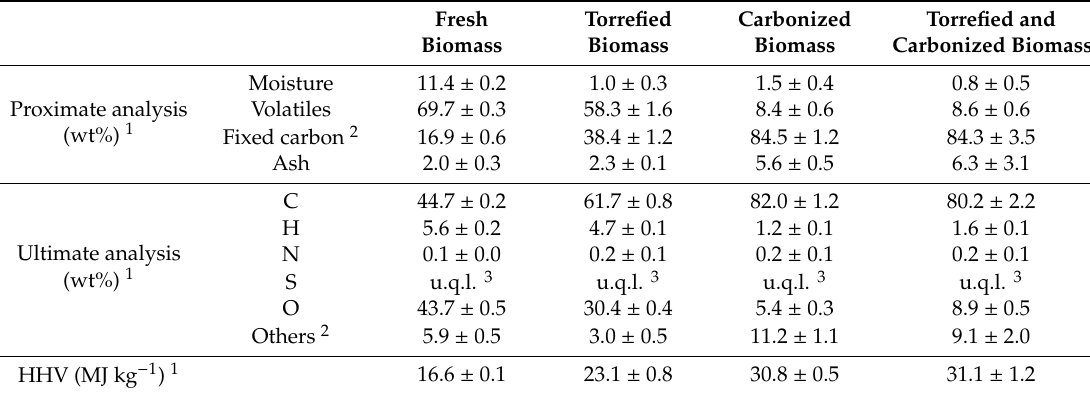
Table 4. Characterization of the solid samples.